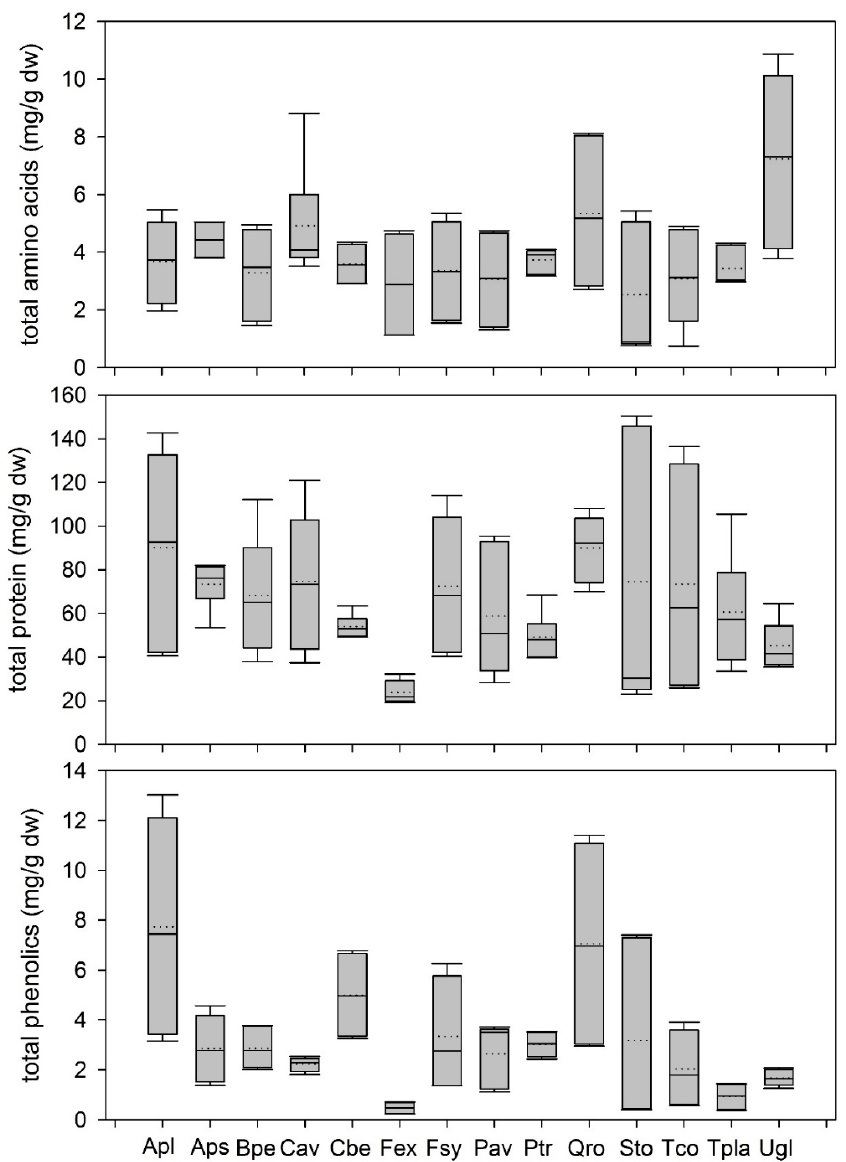
Figure 2. Total soluble amino acid ( top ), protein ( center ), and phenolic ( bottom ) concentration (mg/g dw) in leaf litter. Boxplots show mean (dotted line) and median (straight line) for the combined years. Apl = Acer platanoides , Aps = Acer pseudoplatanus , Bpe = Betula pendula , Cav = Corylus avellana , Cbe = Carpinus betulus , Fex = Fraxinus excelsior , Fsy = Fagus sylvatica , Pav = Prunus avium , Ptr = Populus tremula , Qro = Quercus robur , Sto = Sorbus torminalis , Tco = Tilia cordata , Tpla = Tilia platyphyllos , Ugl = Ulmus glabra